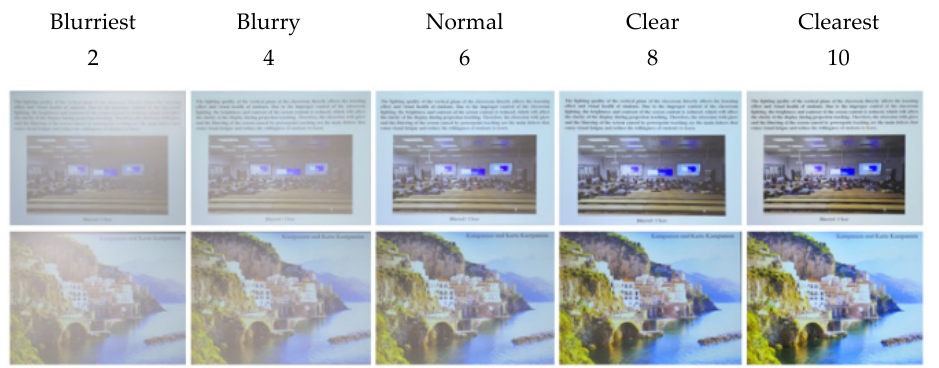
Figure 5. The scales of clarity.